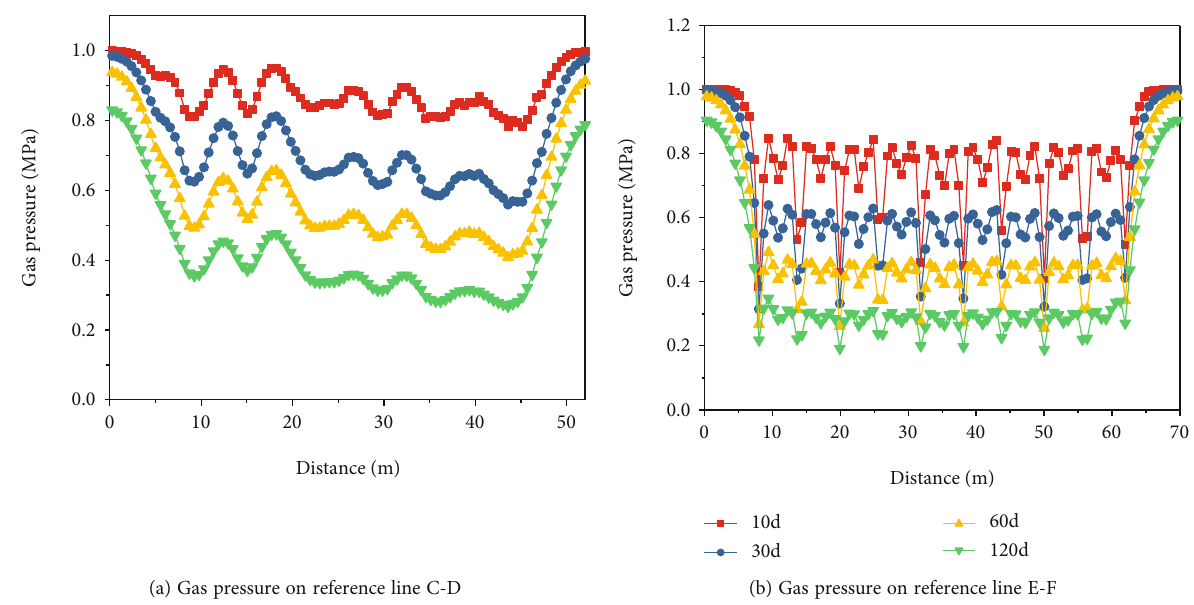
Figure 7: Gas pressure along the reference lines in coal seam after di ff erent extraction times.